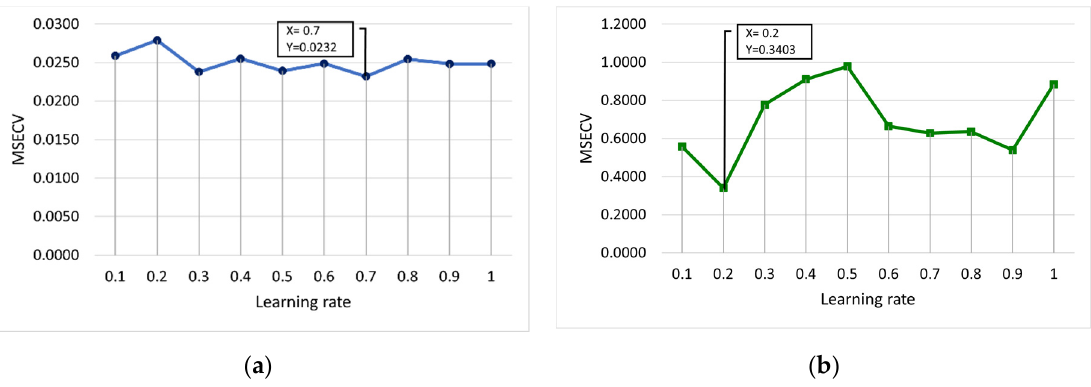
Figure 6. MSECV with varying values of the learning rate for ( a ) FFNN-lm and ( b ) FFNN-gdm.